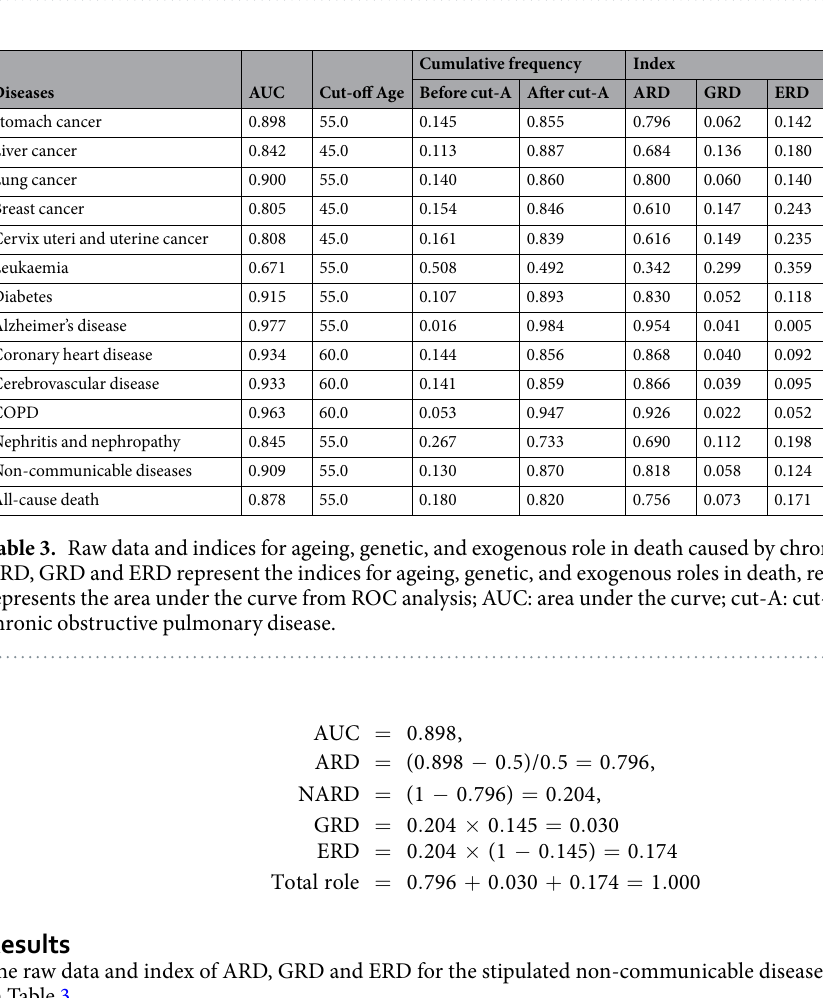
Figure 2. ROC analysis to calculate the age of deaths from stomach cancer as an example.